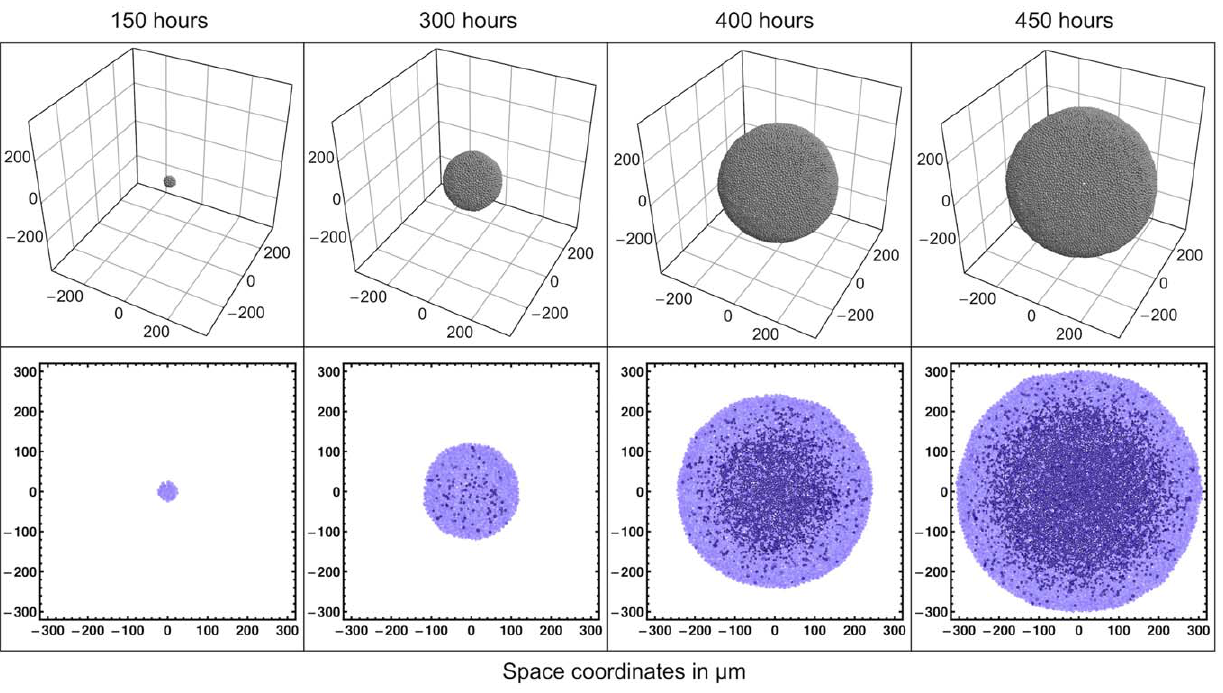
Figure 2. Snapshots of one simulated spheroid taken at different times. As the spheroid grows, a necrotic core develops in its central region, just as it happens in real spheroids. The size of the necrotic core and of the viable cell rim match real measurements.